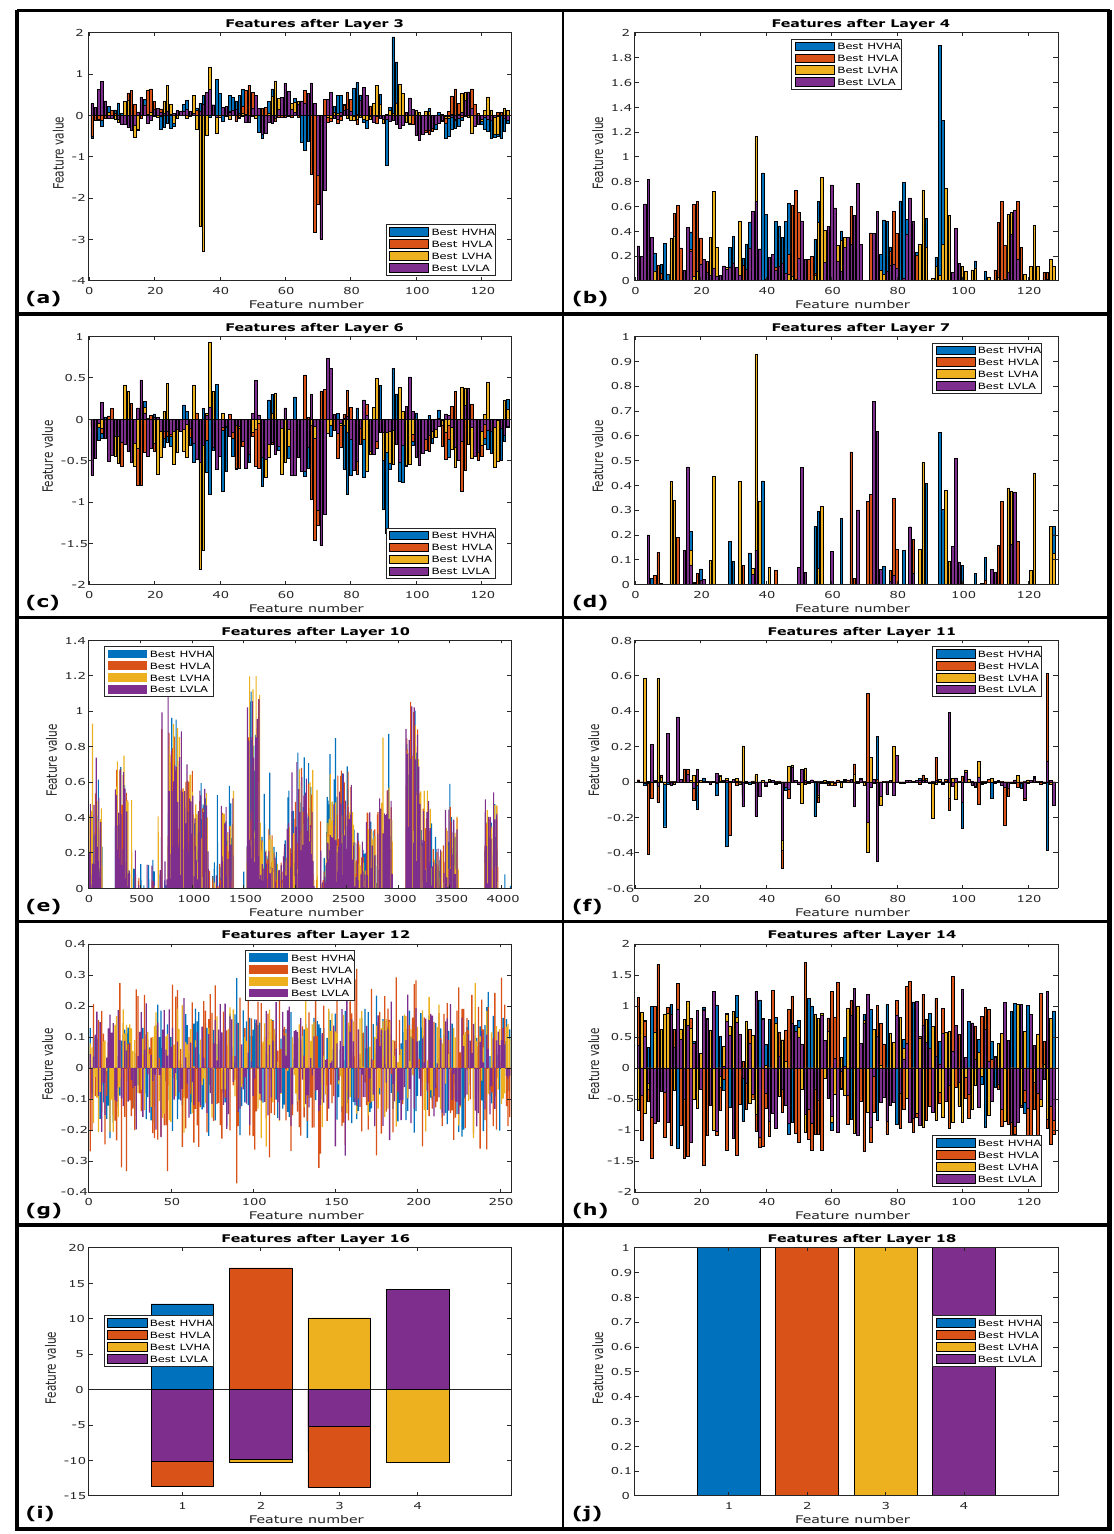
Figure 10. ( a ) Best class-wise features after first convolution layer. ( b ) Best class-wise features after first ReLU layer. ( c ) Best class-wise features after second convolution layer. ( d ) Best class-wise features after second ReLU layer. ( e ) Best class-wise features after flatten layer. ( f ) Best class-wise features after LSTM layer. ( g ) Best class-wise features after FC1 layer. ( h ) Best class-wise features after FC2 layer. ( i ) Best class-wise features after FC3 layer. ( j ) Best class-wise predictions after SoftMax